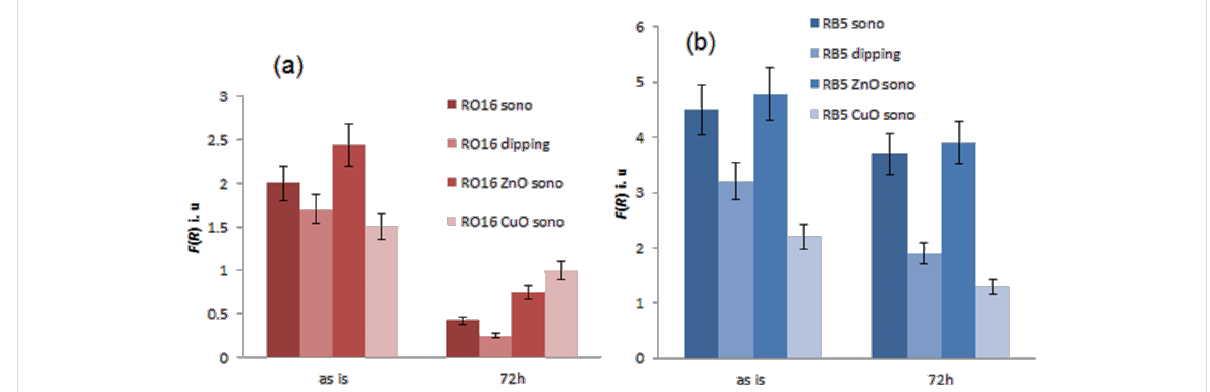
Figure 8: Comparison of dye stability after leaching in saline solution for 72 h at 40 °C and shaking at 100 rpm for the colored bandages coated with RO16 (a) or RB5 (b) and ZnO or CuO NPs. The data is for three independent experiments.